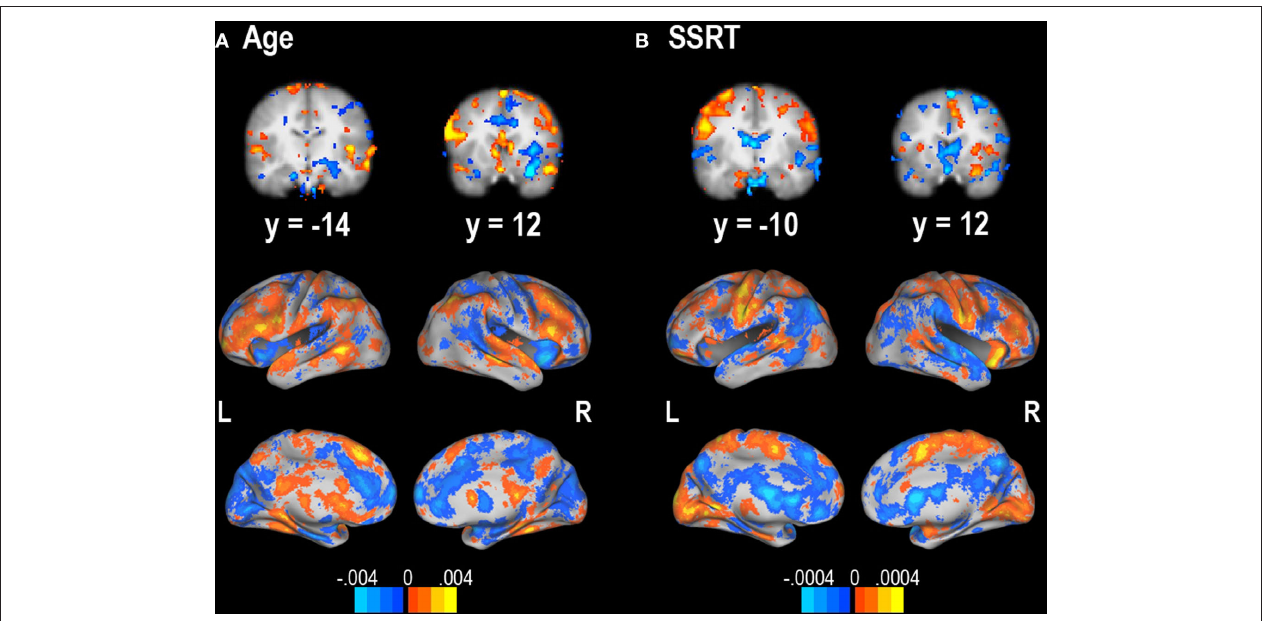
that negatively predict the label value. The color bars indicate the scale for each contrast. It is important to note that these regions may reflect the sensitivity of a particular classifier and could potentially change with different